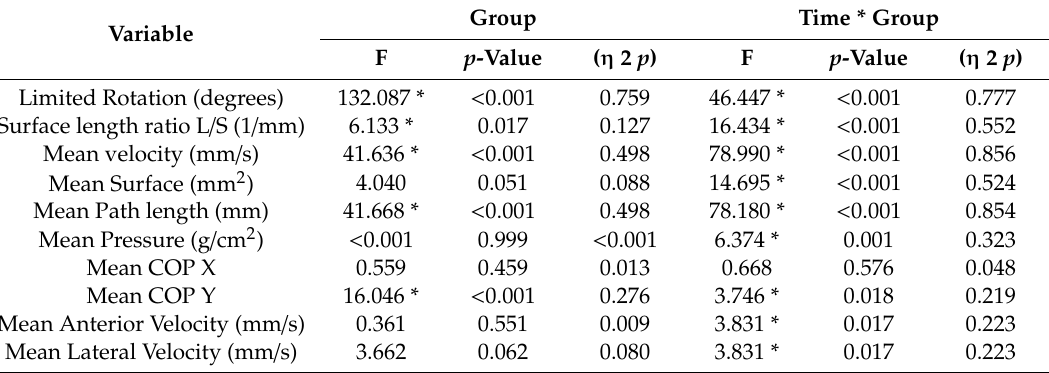
Table 2. Inferential statistics analysis for the group factor and the interaction between factors (time * group) with two-way repeated measures ANOVA. E ff ect size was calculated as the partial eta squared ( η 2 p ). Group Time * Group Variable F p -Value ( η 2 p ) F p -Value ( η 2 p ) Limited Rotation (degrees) 132.087 * < 0.001 0.759 46.447 * < 0.001 0.777 Surface length ratio L / S (1 / mm)